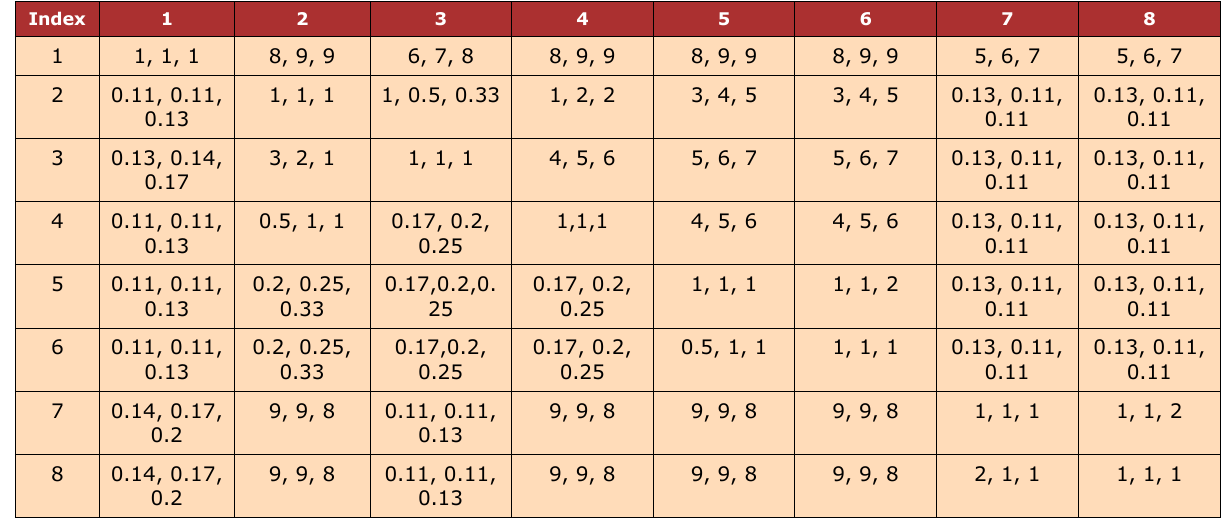
Table 8. Pair wise comparison